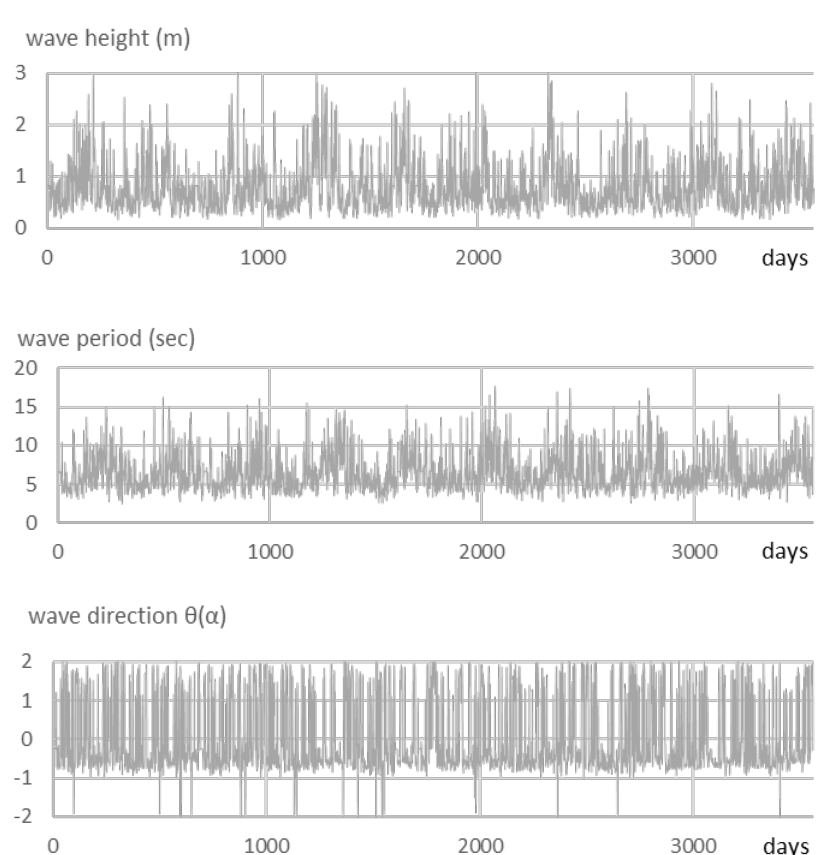
Figure 7. Time series of the simulated daily wave data in the time period: 1 July 2003 to 31 March 2013.